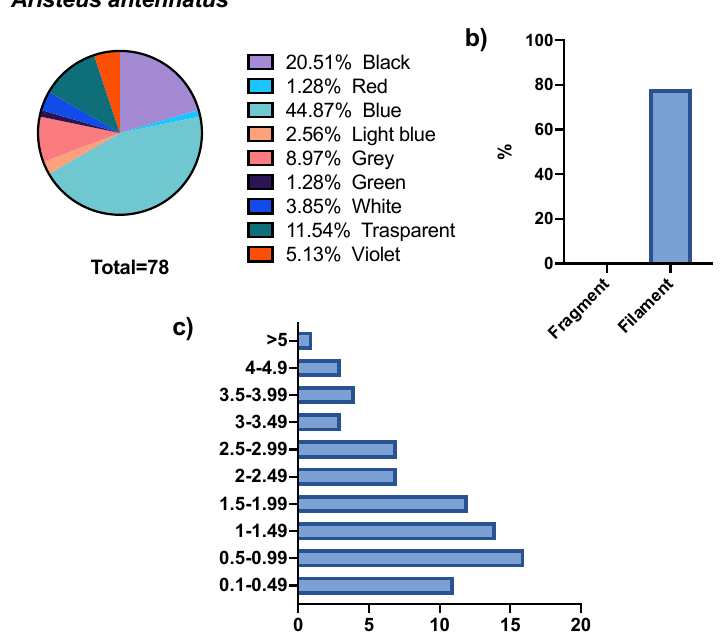
Figure 3. Abundance, colors ( a ), shape ( b ), and size ( c ) of microparticles isolated from A. antennatus .